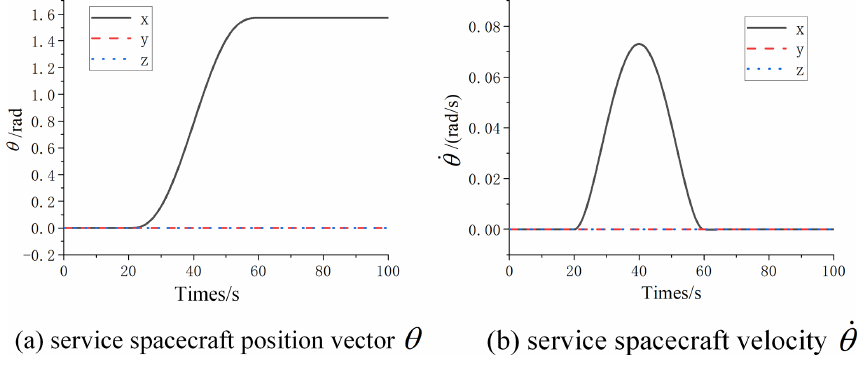
Figure 7. Service spacecraft attitude motion state.